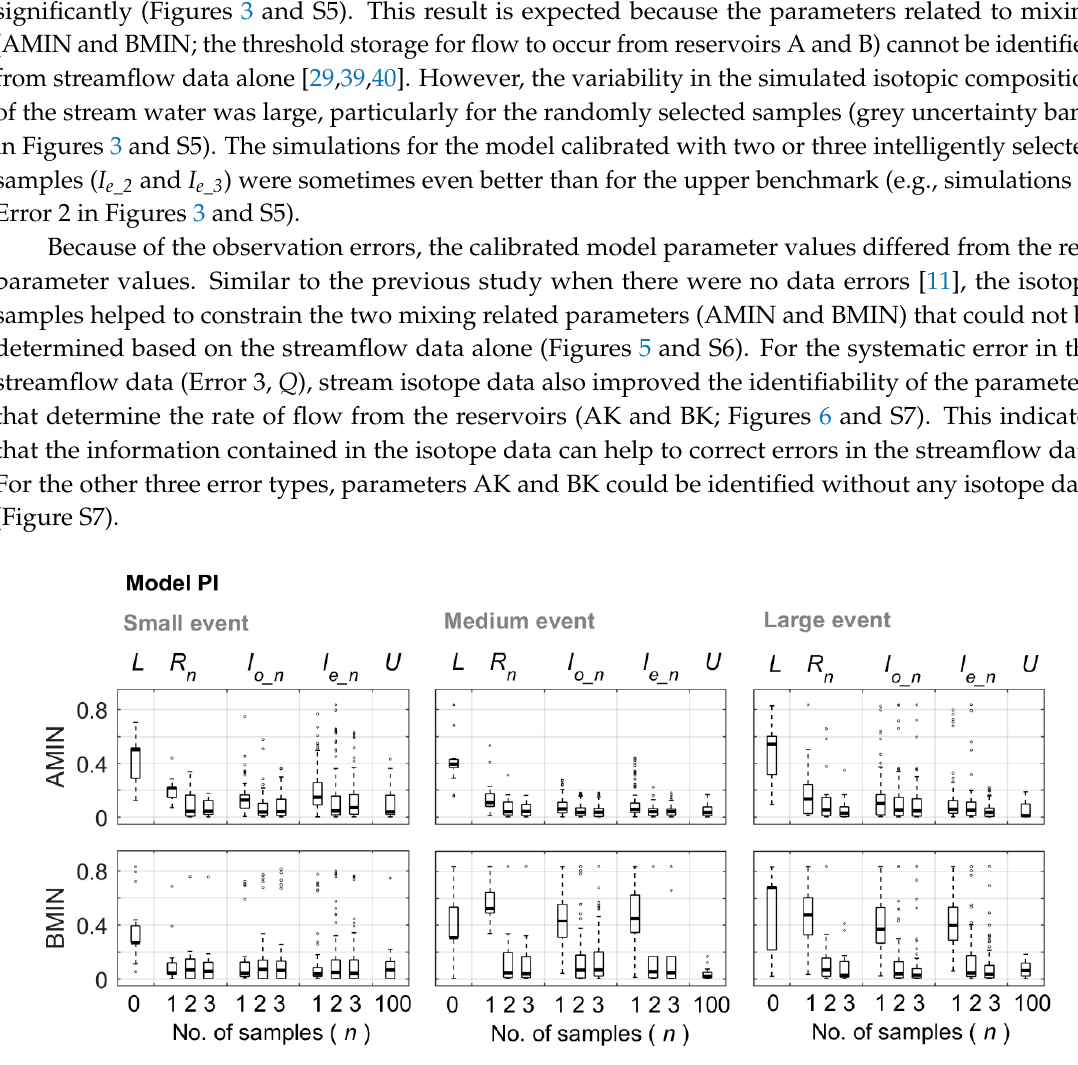
Figure 5. Box plots of the relative parameter error for parameters AMIN and BMIN, showing the effect of the sampling strategy and the number of samples on parameter identifiability. The relative parameter error is defined as the absolute difference between the calibrated and real parameter value divided by the initial parameter range used for calibration (i.e., difference between maximum and minimum parameter value used in calibration). Each box plot contains the results for the four different errors and the five different error magnitudes. The bottom and top of the box represent the 25th and 75th percentiles, the thick line represents the median, the whiskers extend to the most extreme data points that are not considered outliers, and the dots represent the outliers.